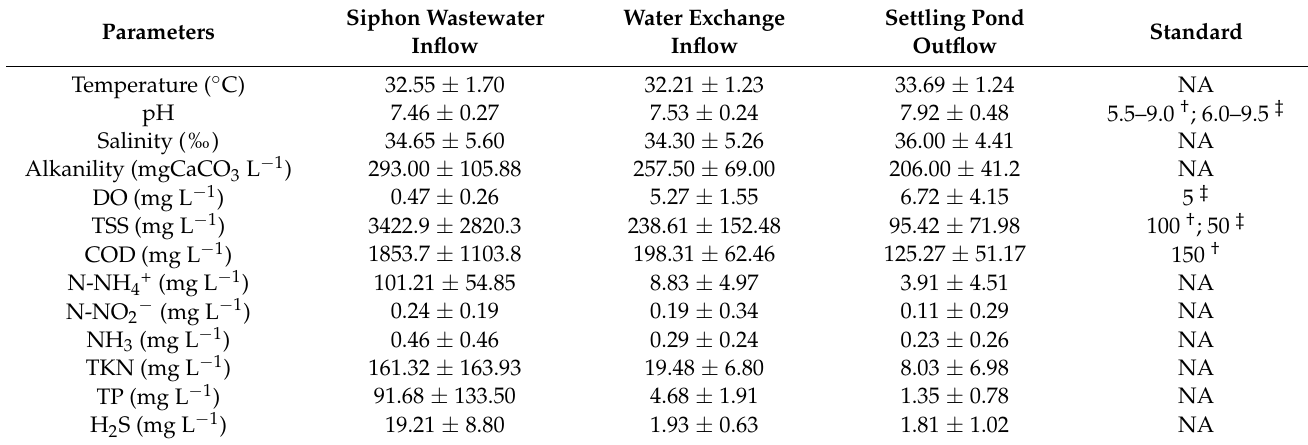
Table 1. Characteristics of super-intensive shrimp farming